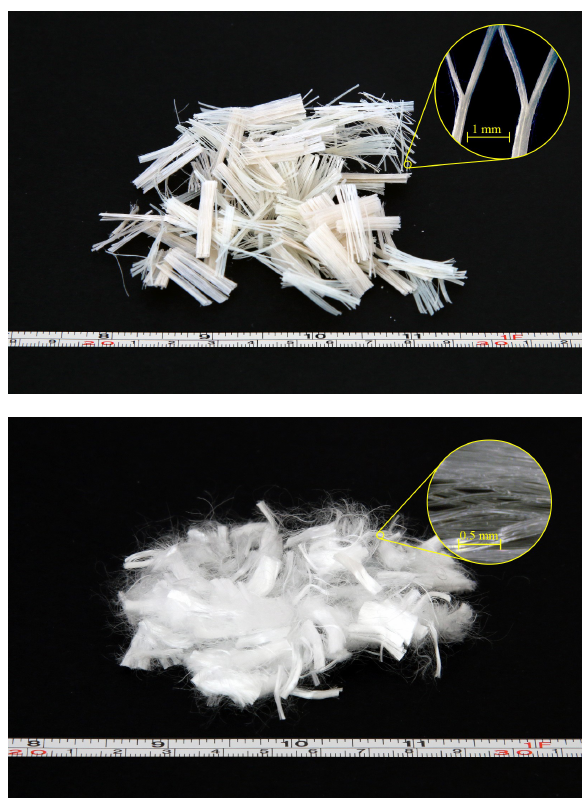
Figure 2. Top – Polypropylene macro-fibers, Bottom – Polypropylene